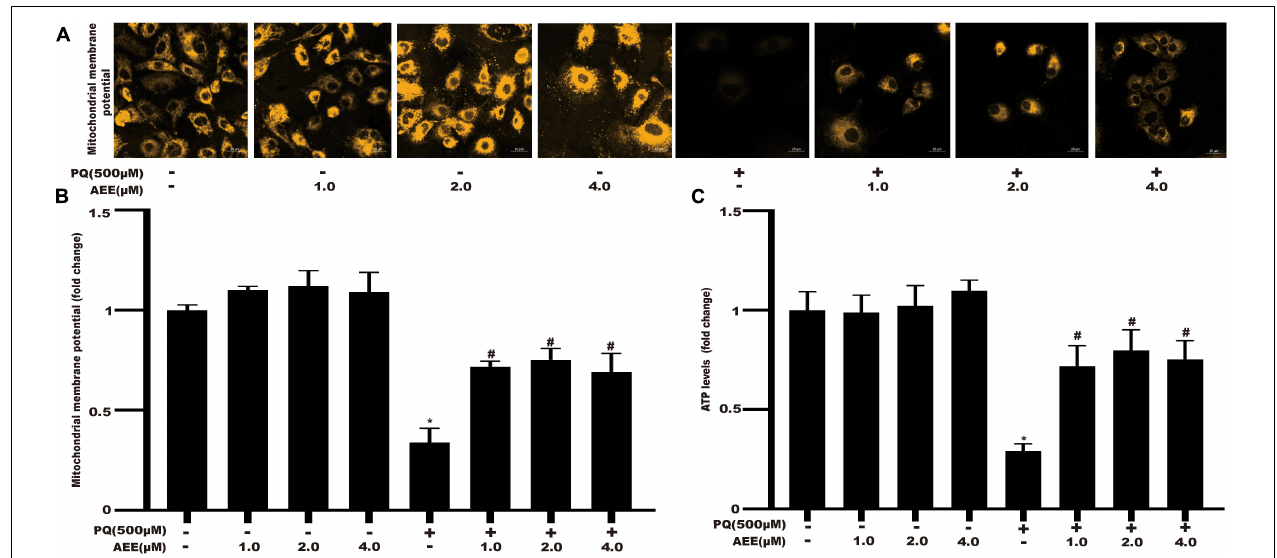
FIGURE 3 | AEE alleviates PQ-induced mitochondrial dysfunction in BRL-3A cells. (A,B) The mitochondrial membrane potential ( (cid:49)(cid:57) m) of BRL-3A cells was measured in different treatment groups. Scale bar: 20 µ m. (C) The ATP level of BRL-3A cells was measured in different treatment groups. Values are presented as the means ± SD where applicable ( n = 6). * p < 0.05 compared with the control group; # p < 0.05 compared with the PQ